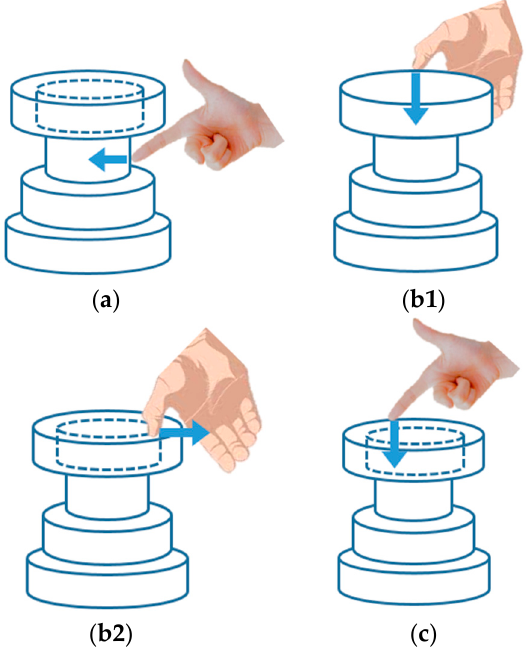
Figure 5. User-model interaction: ( a ) shaping the external surface = index finger; ( b1 ) forming the inner shape: deepening the opening = thumb; ( b2 ) forming the inner shape: widening the opening = thumb; ( c ) reducing the total height = index finger.